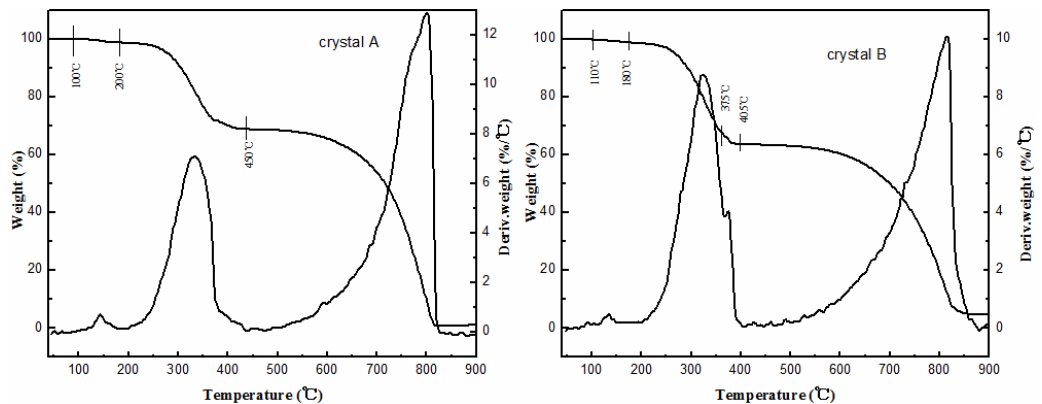
Figure 6. TG/DTG thermograms for the crystal A and crystal B.